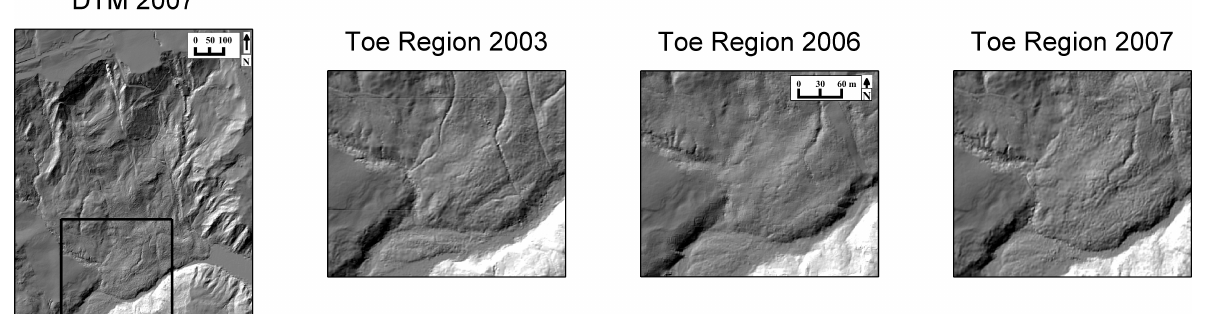
Figure 9. Shaded DTM of the landslide toe area from 2003 to 2007.